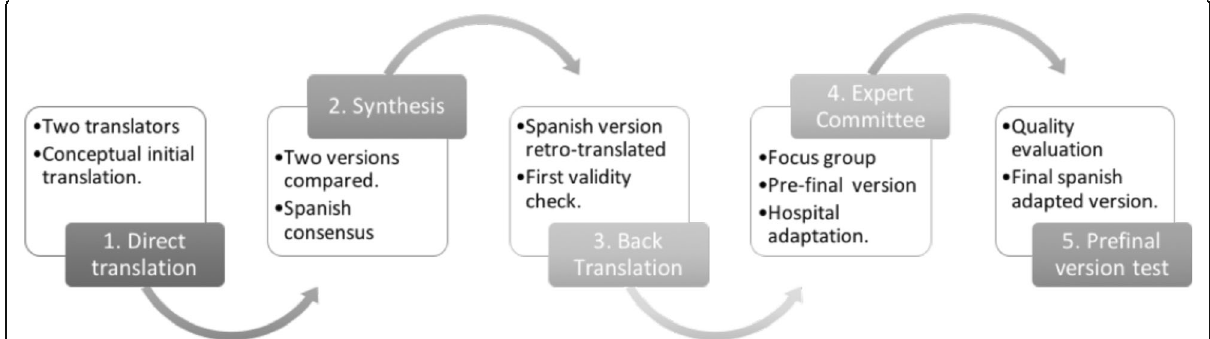
Fig. 1 Cross-cultural linguistic and contextual adaptation